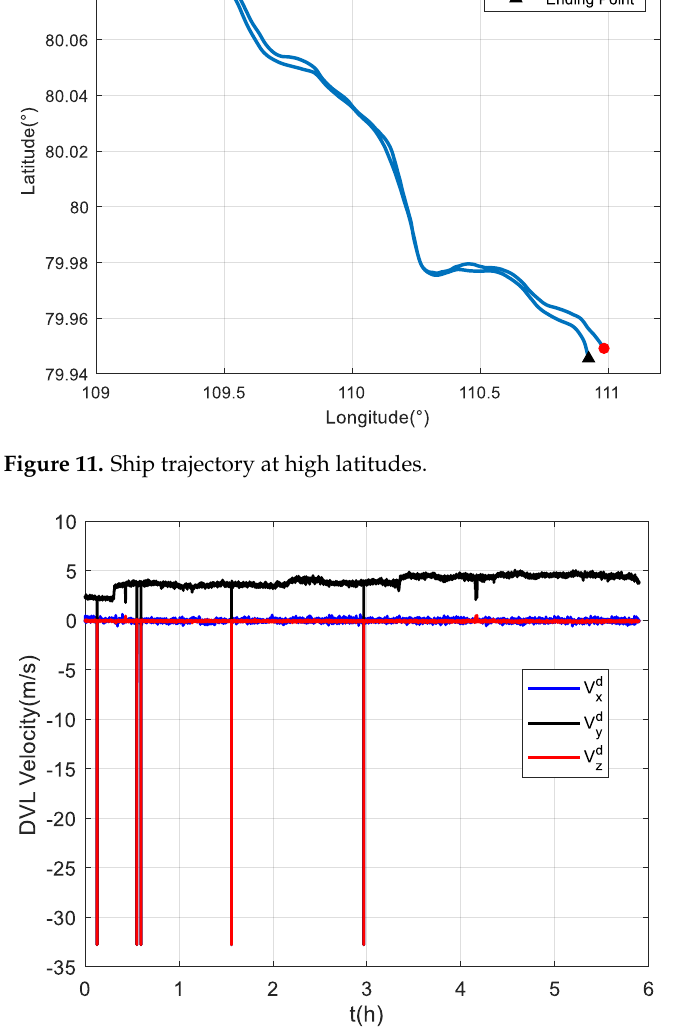
Figure 12. The simulated velocity outputs of the DVL at high latitudes.